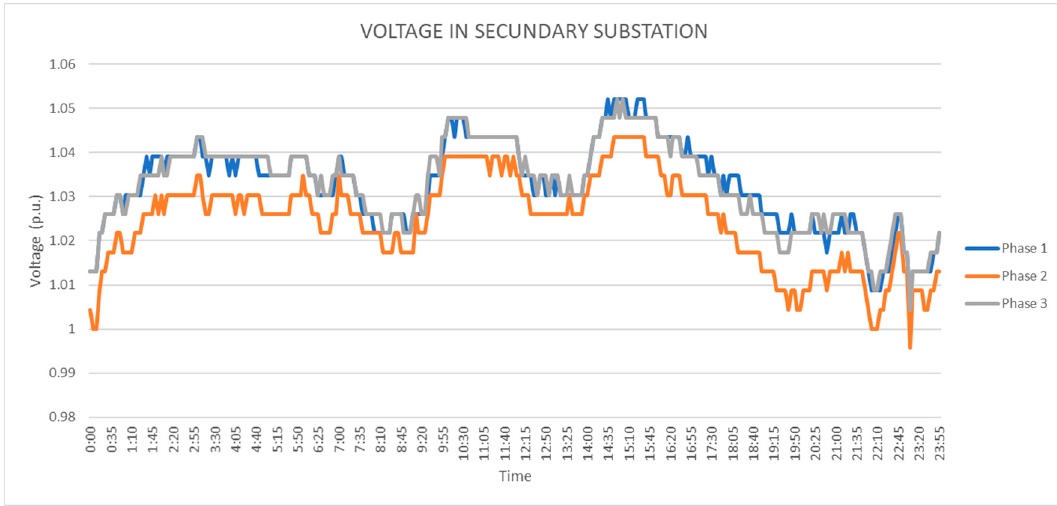
Figure A3. Voltage in secondary substation.